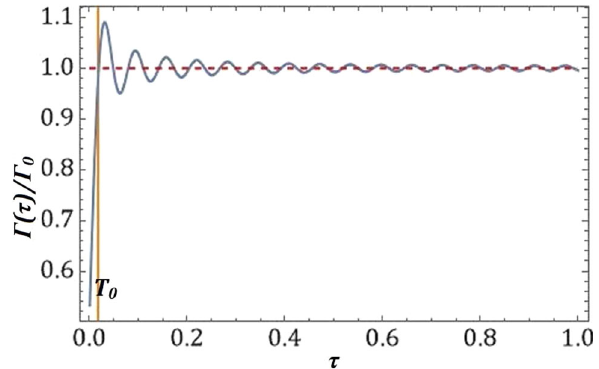
Fig. 1 A typical form of the survival probability P (τ) . Here τ = t τ = ¯ h 0 τ 0 . Γ 0 is the lifetime, t is the time. The case